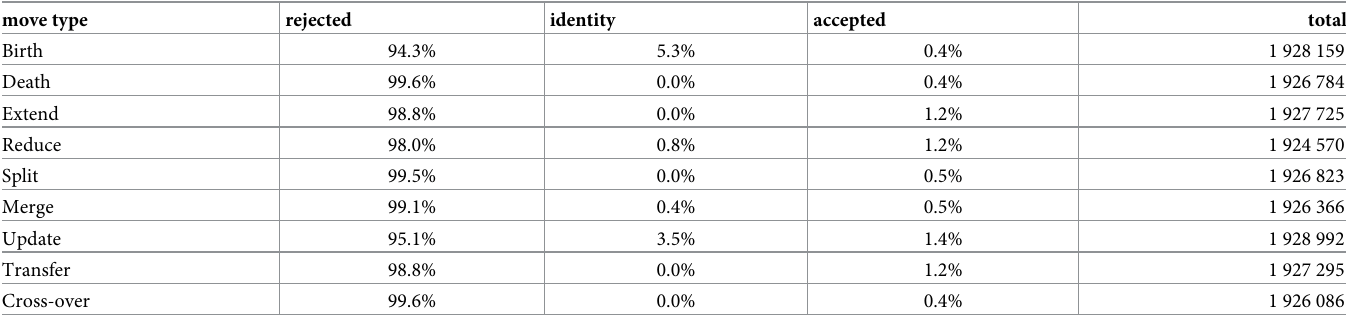
Table 1. Statistics of the move types for one sampler chain. Data set SMM–9761.